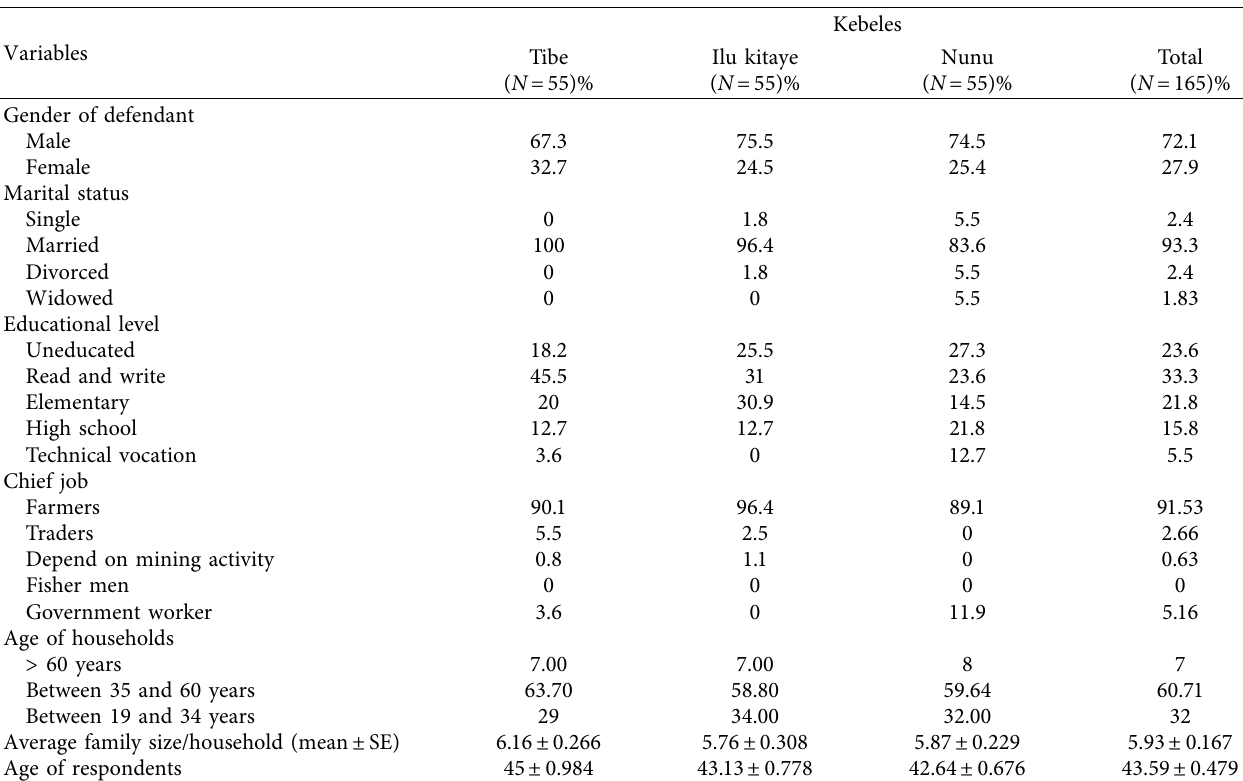
Table 1: Demographic features of defendants in the survey parts.